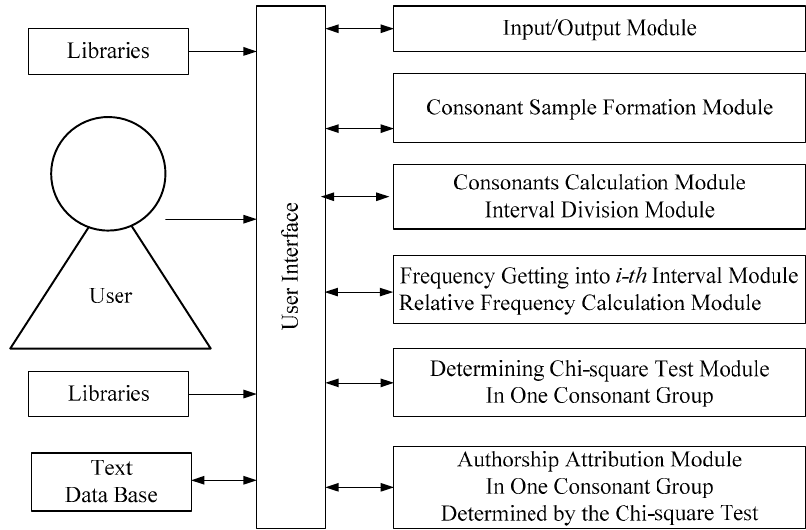
Figure 1. The structure of the developed program system.